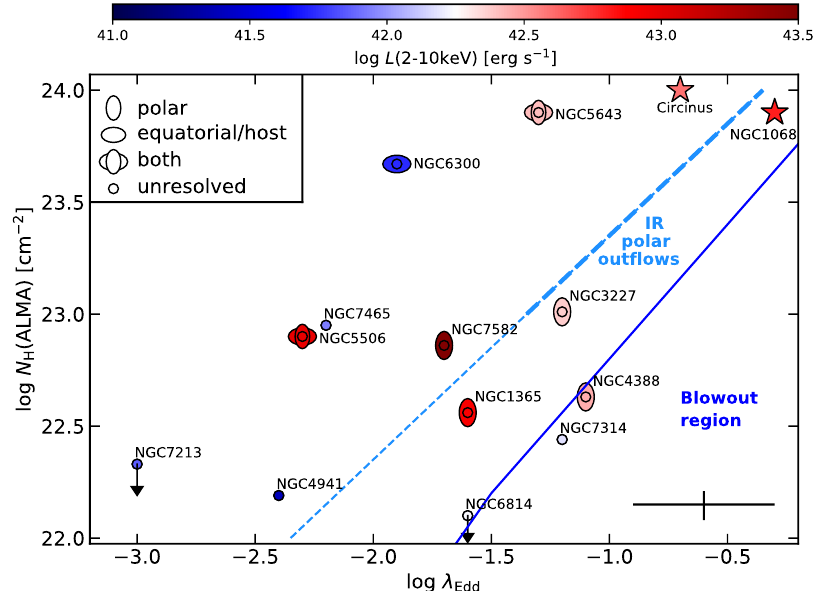
Figure 11. An illustration on the dependence of mid-IR continuum morphology (as presented in Fig. 4. Diagram showing the nuclear hydrogen column densities against the Eddington ratios for the GATOS Seyferts. The hydrogen column densities are from ALMA CO(3-2) based H 2 estimates at the AGN position from GB21. The symbols are color-coded in terms of the intrinsic the symbols) on the Eddington ratio and column density for a sample of local Seyferts. To the right 2 10keV luminosities. The di ↵ erent symbols indicate the mid-IR morphologies (see Table 2). Circinus and NGC 1068, which are marked with  starsymbols,alsoshowpolarmid-IRemissionbutarenotincludedinoursample.Theerrorbarsrepresenttypicaluncertaintiesintheobservations, of the solid line is the region where the AGN wind is able to blowout all surrounding material. To namely, 0.3dex for the Eddington ratios and a 15% uncertainty in the absolute flux calibration of the ALMA data. Below the solid curve from Fabian et al. (2008) is the blowout region where outflows are likely to clear material in the nuclear regions (see also Ricci et al. 2017b). The dashed the right of the dashed line is where IR polar outflows are expected to develop, consistent with line from Venanzi et al. (2020) indicates the limit where the AGN radiation acceleration balances gravity and the IR radiation pressure dominates the observations. Both Circinus and NGC1068 also show polar dust emission, although not part of giving rise to polar dusty outflows. Their radiation-dynamical simulations were for a column density range N H with the thicker dashed line. this particular study which is why they are given different symbols. Reproduced with permission from Alonso-Herrero et al. [141], ESO ©